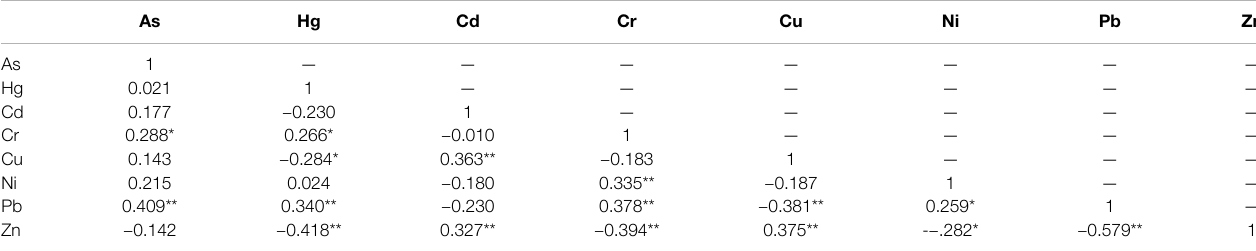
TABLE 2 | The correlation coef fi cients of heavy metal contents in the soil in the dairy farm. As Hg Cd Cr Cu Ni Pb